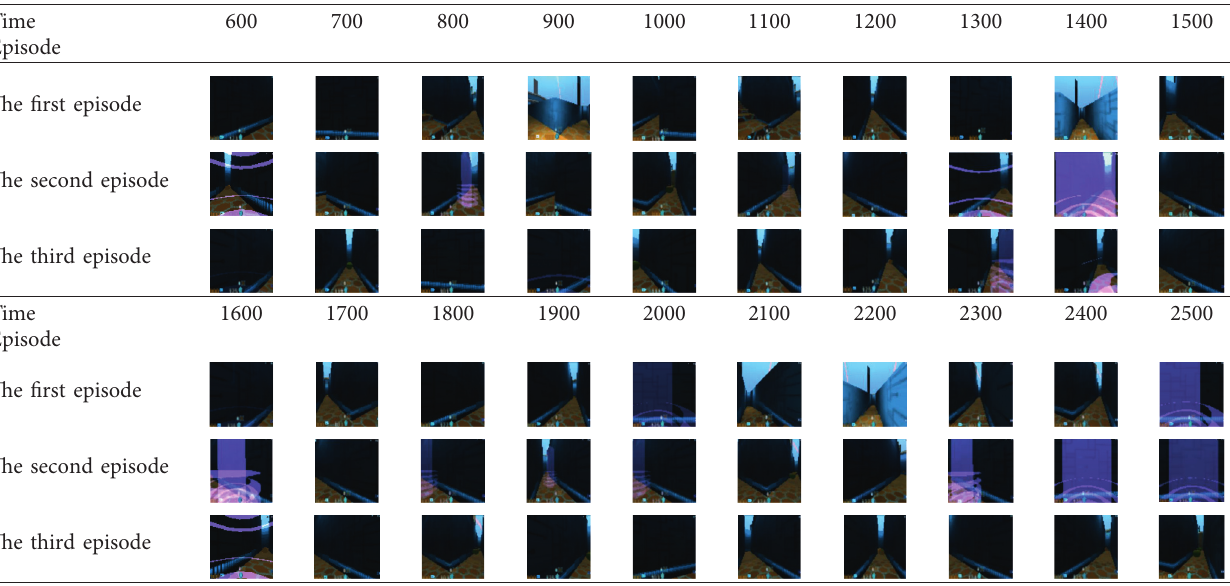
Table 1: The states that the artificial agent sees in stairway_to_melon